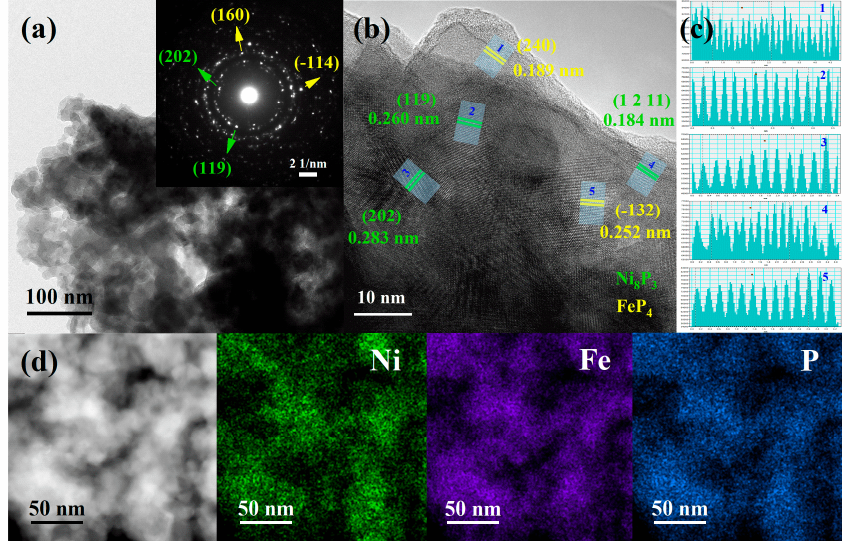
Figure 3. ( a ) TEM image of e − NFP scrapped from NFF; the inset image is the corresponding SAED pattern. ( b ) HRTEM image of e − NFP. ( c1 − 5 ) lattice spacing of e − NFP corresponding to the blue rectangles in panel b. ( d ) EDS elemental mapping of e − NFP.